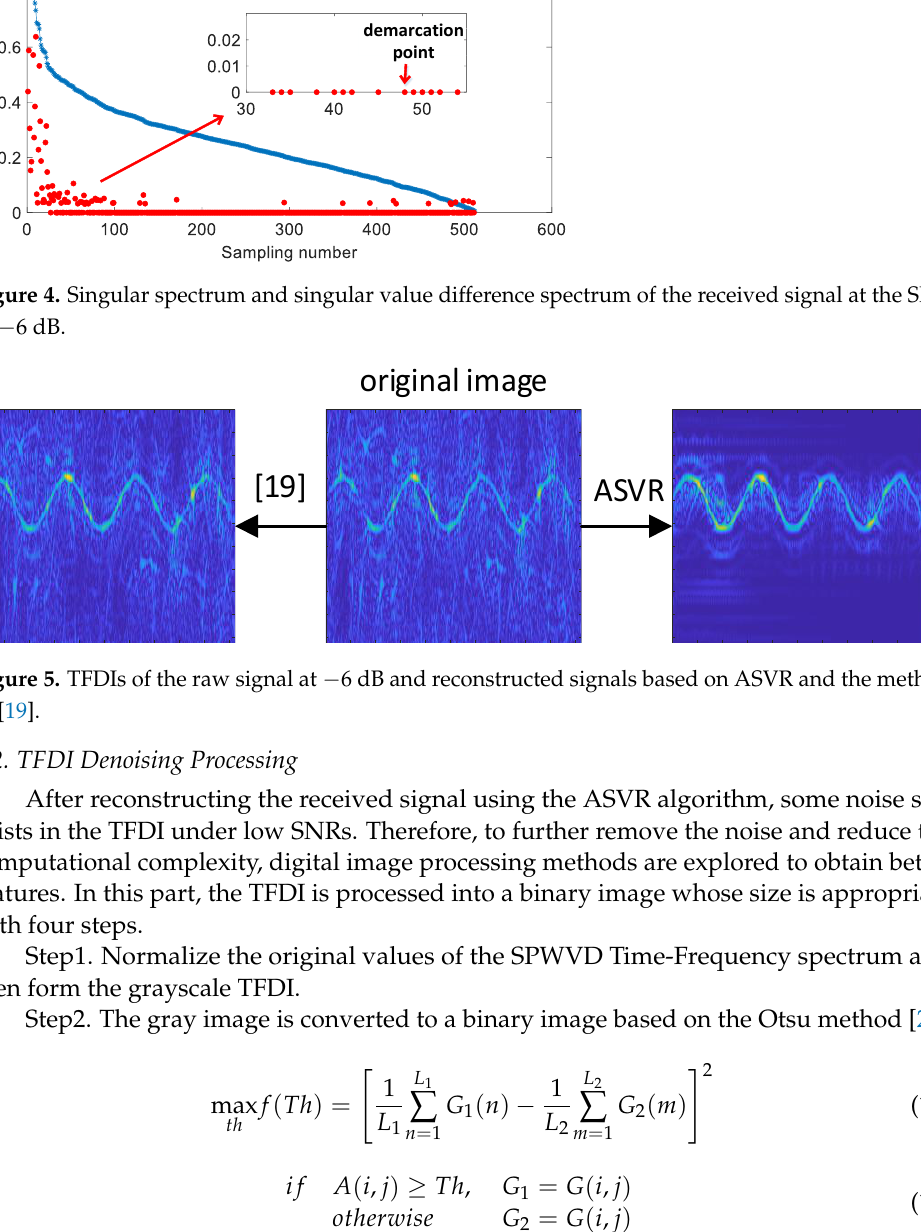
Figure 4. Singular spectrum and singular value difference spectrum of the received signal at the SNR of −6 dB.